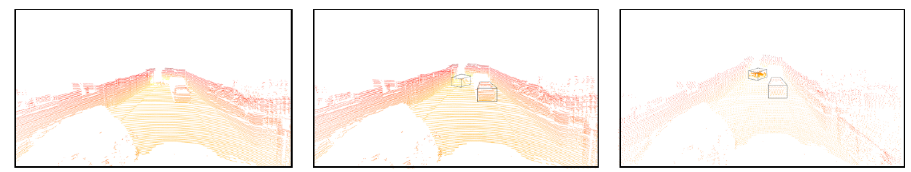
Figure 10. Critical area prediction and scene rescan based on Parallel